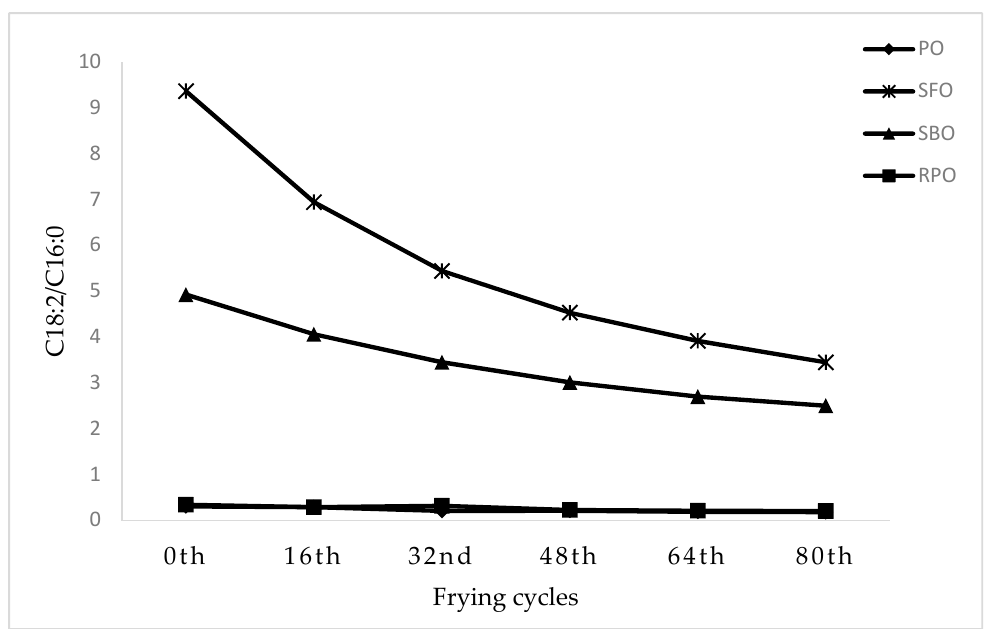
Figure 1. Changes in the ratio of C18:2/C16:0 across 80 frying cycles in PO, palm olein; SFO, sunflower oil; SBO, soy bean oil; RPO, red palm olein.